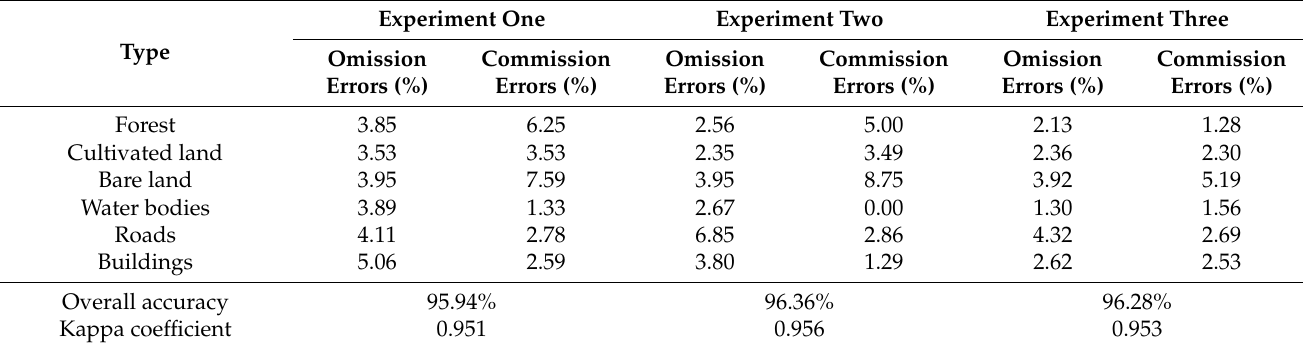
Table 8. The accuracies of change detection result based on the proposed method in the three experiments. Experiment Type